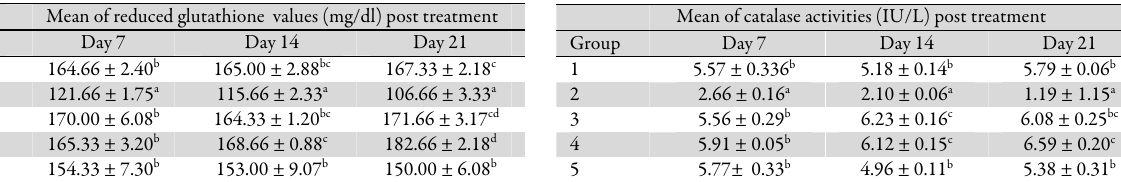
significant difference at p < 0.05 Table 10. The mean of catalase activities of alloxan induced diabetic rats treated with combinations of glibenclamide and aqueous extract of G. latifolium